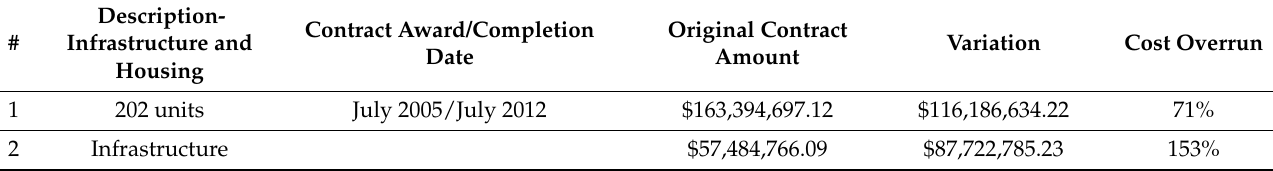
Table 1. Analysis of project performance within 2005–2018 (constant prices)